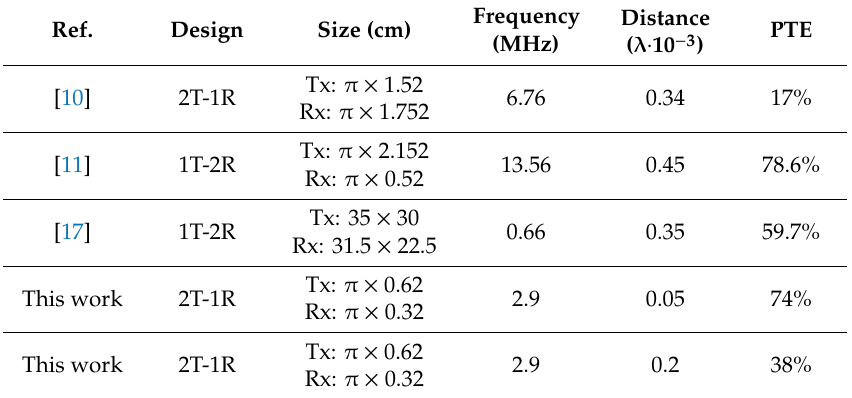
Figure 9. PTE measurements for the proposed 3-coil system and typical 2-coil system. Table 4. Comparison with previous